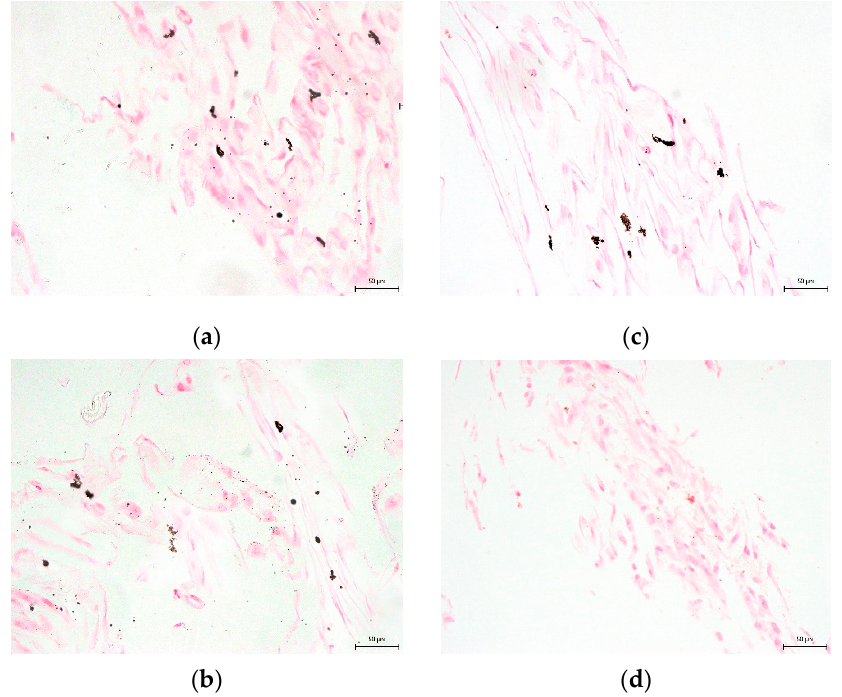
Figure 11. The presence of calcium phosphate deposits in the extracellular osteogenic matrix. Samples of lineage DPSCs are after 3-week cultivation in osteogenic differentiation medium. Calcium phosphate deposits are colored as brown–black areas: ( a ) 10% DMSO cryomedium; ( b ) 3% DMSO cryomedium; ( c ) 3% DMSO + 0.1% HMW-HA cryomedium; ( d ) non-differentiated DPSCs. Scale bar 50 µm.